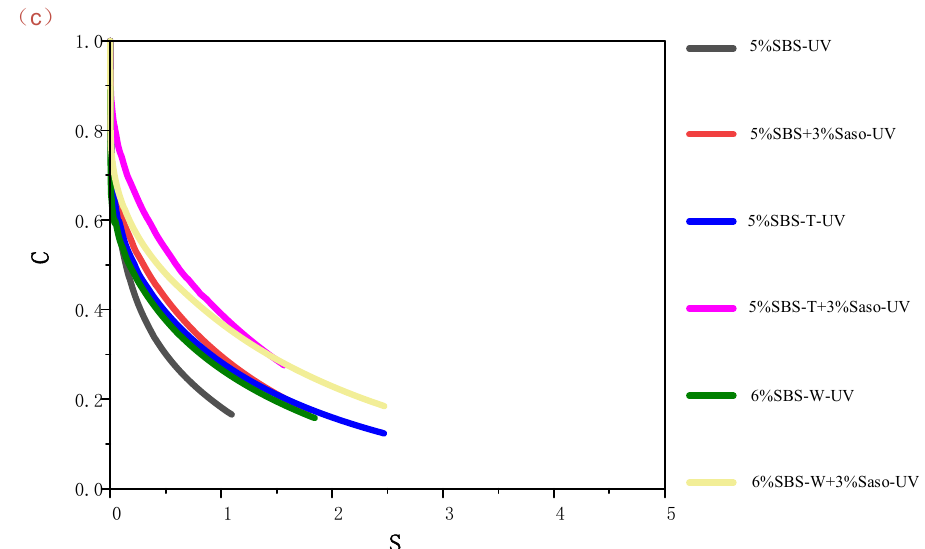
Figure 7. DCC curves of modified asphalt binder: ( a ) SBS/Saso; ( b ) SBS-T/Saso; ( c ) SBS-W//Saso.